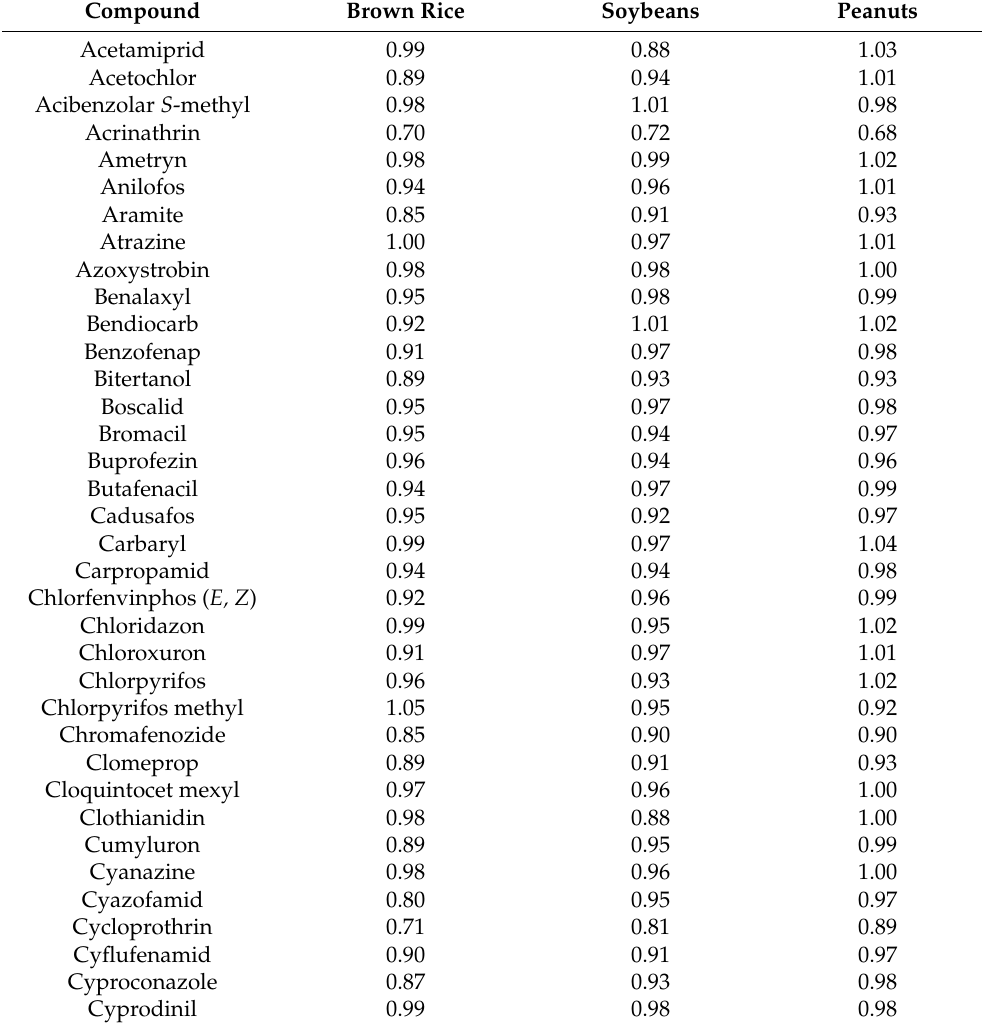
Table 3. Matrix effects of the target pesticides in brown rice, soybeans, and peanuts. Compound Brown Rice Soybeans